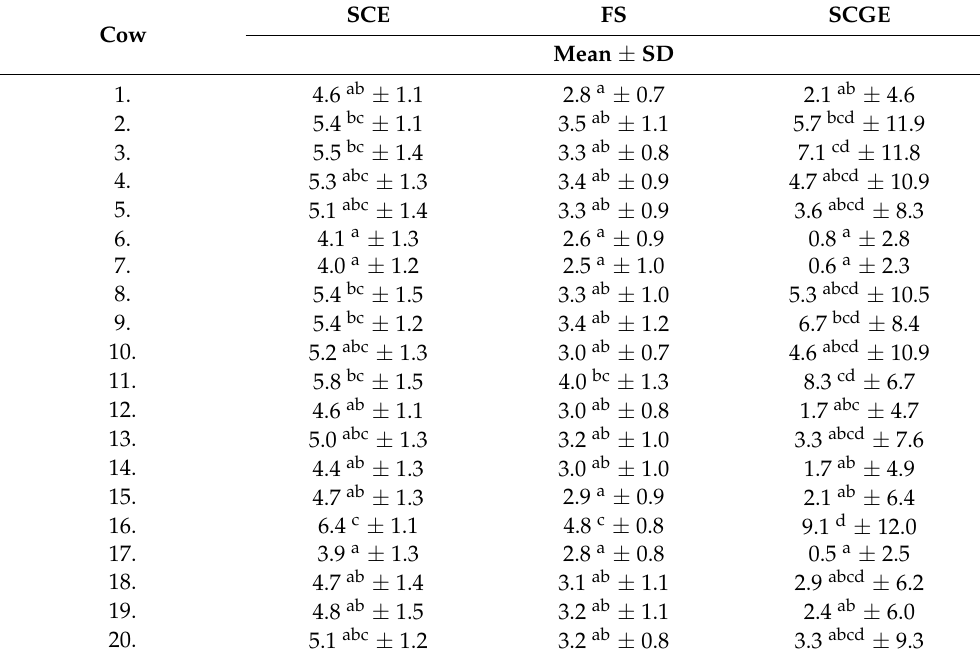
Table 1. Number of instabilities identified (SCE, FS, and SCGE) in cows. Means designated with different letters vary significantly at p < 0.05.